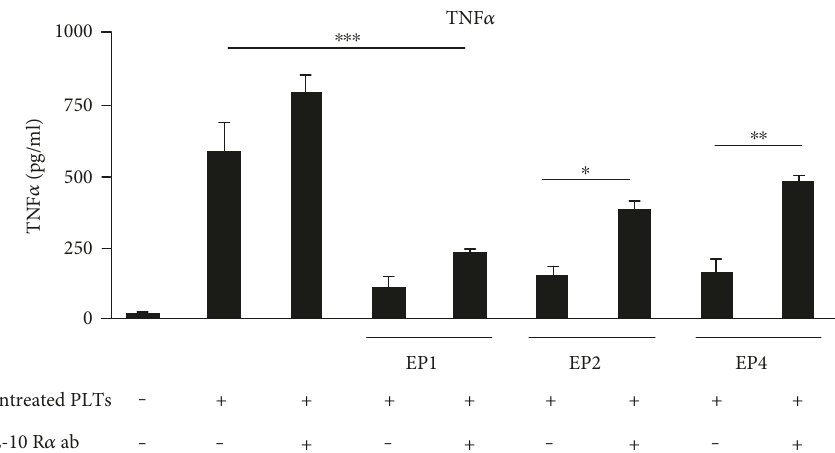
Figure 4: EP2 and EP4 decrease TNF α through IL-10 and its receptor IL-10 R. Murine BMDM were incubated alone or with untreated platelets ± IL-10 R α antibody (9 μ g/ml) 30 minutes before the application of the respective EP agonist concentrations for 3 hours (40 nM ONO-Di-004, 100 nM butaprost, 5nM L-902,688, 30 nM PGE ). TNF α was determined by ELISA. Data are presented as mean ± SEM 2 from 4 preparations. One-way ANOVA/Bonferroni ∗ P < 0 05 , ∗∗ P < 0 01 , ∗∗∗ P < 0 002